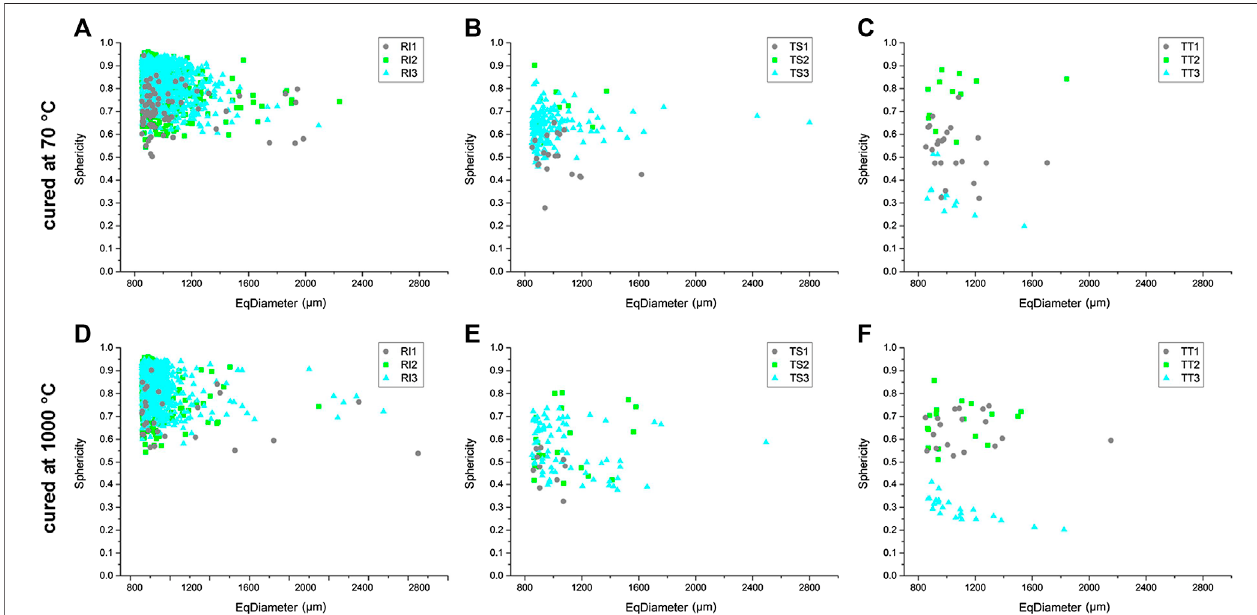
FIGURE 8 | Graphical representation of the sphericity values as a function of pore size of the analyzed alkali-activated foams cured at 70 (A) – (C) and 1,000 ° C (D) – (F) , determined by means of X-ray micro-tomography.